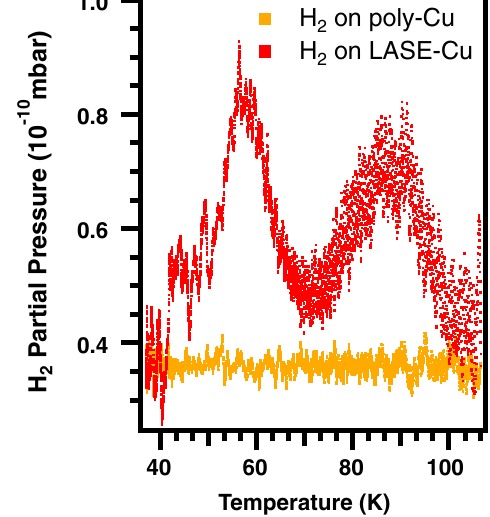
FIG. 6. TPD curves from 100 L of H 2 dosed on the flat poly-Cu and on LASE-Cu